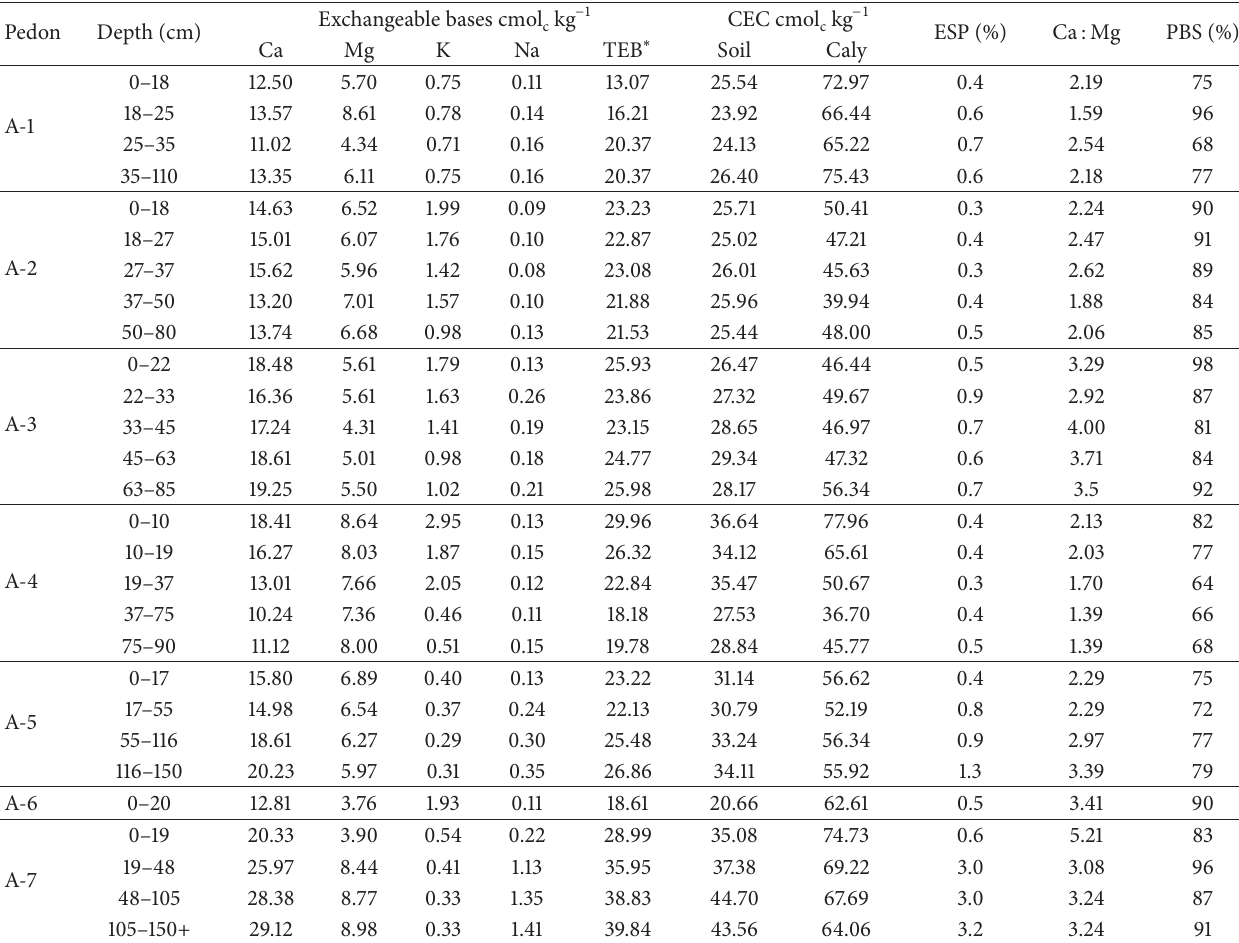
Table 8: Exchangeable bases (Ca, Mg, K, and Na), cation exchange capacity (CEC), calcium to magnesium ratio (Ca:Mg), and percent base saturation (BS) of the